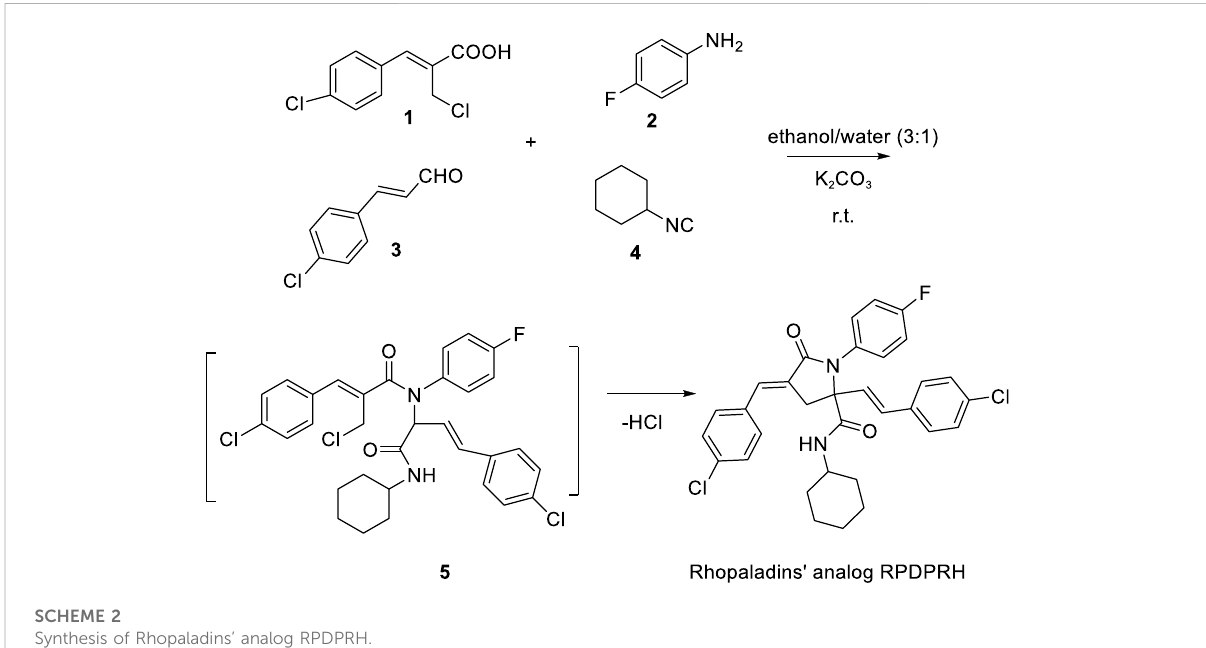
FIGURE 1 Rapamycin, RPDPB and RPDPRH were docked into the complex of FKBP12-mTOR (PDB ID: 1FAP), respectively. Note: (A) : Rapamycin docked into FKBP12-mTOR; (B) : RPDPB docked into FKBP12-mTOR; (C) : RPDPRH docked into FKBP12-mTOR.